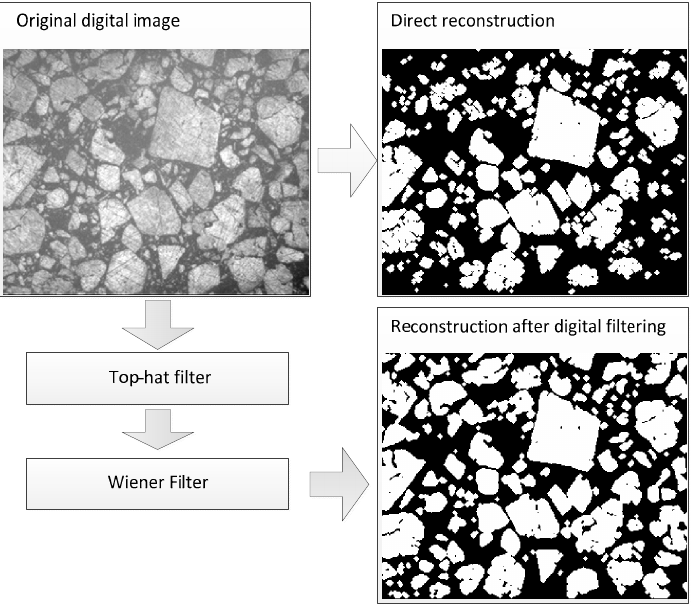
Figure 1. Flow chart of smooth processing in digital image.